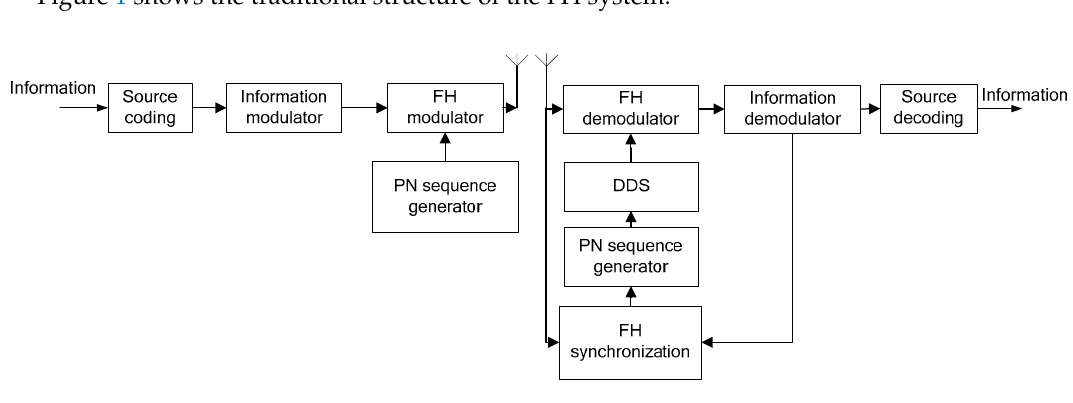
Figure 1. Traditional structure of FH system.